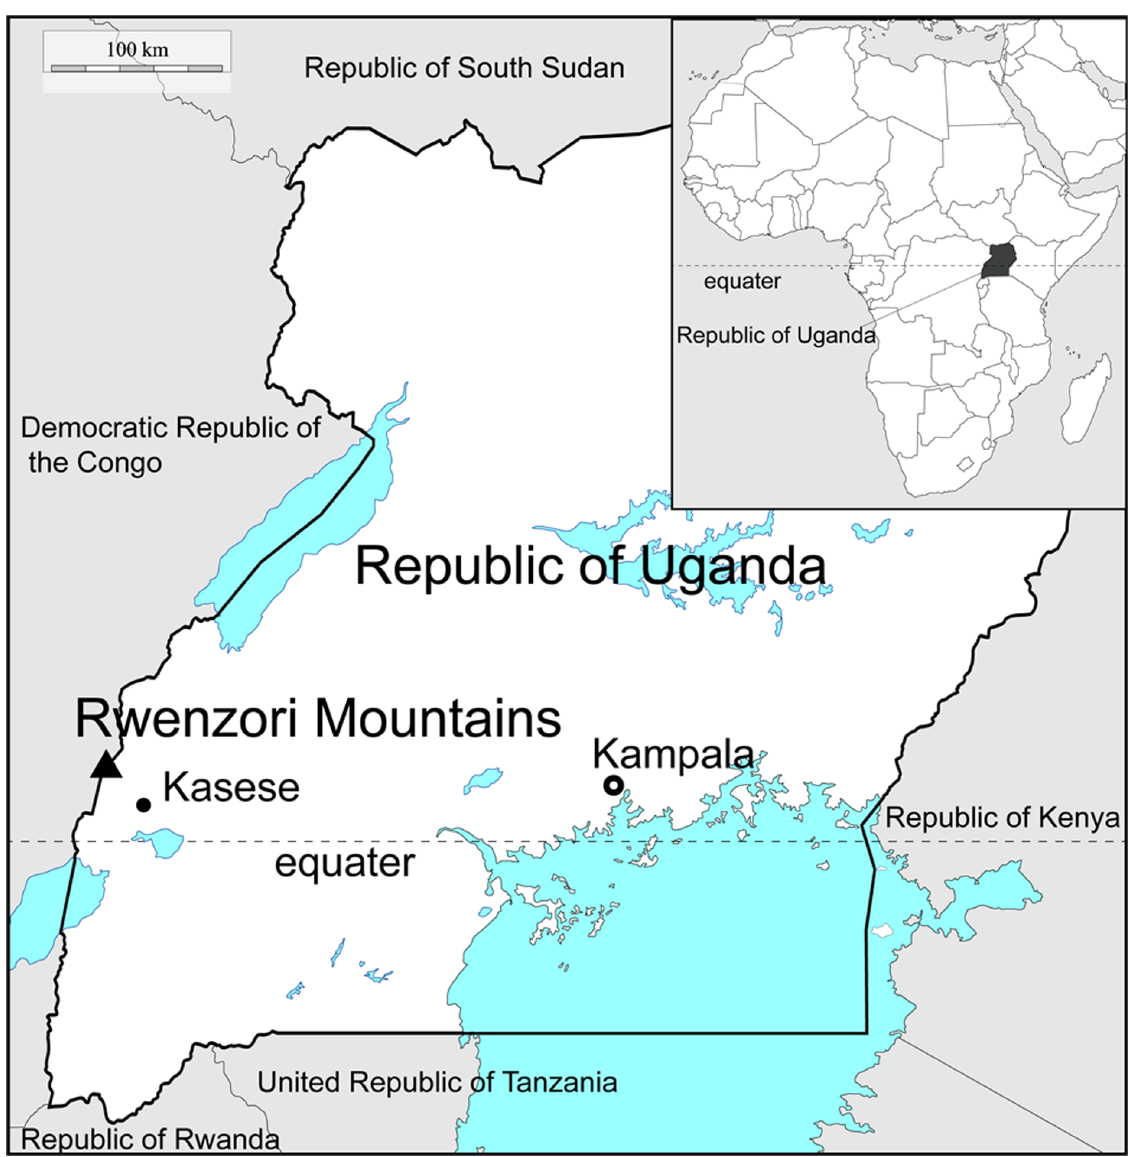
Figure 1. Location map of Rwenzori Mountains in Republic of Uganda.